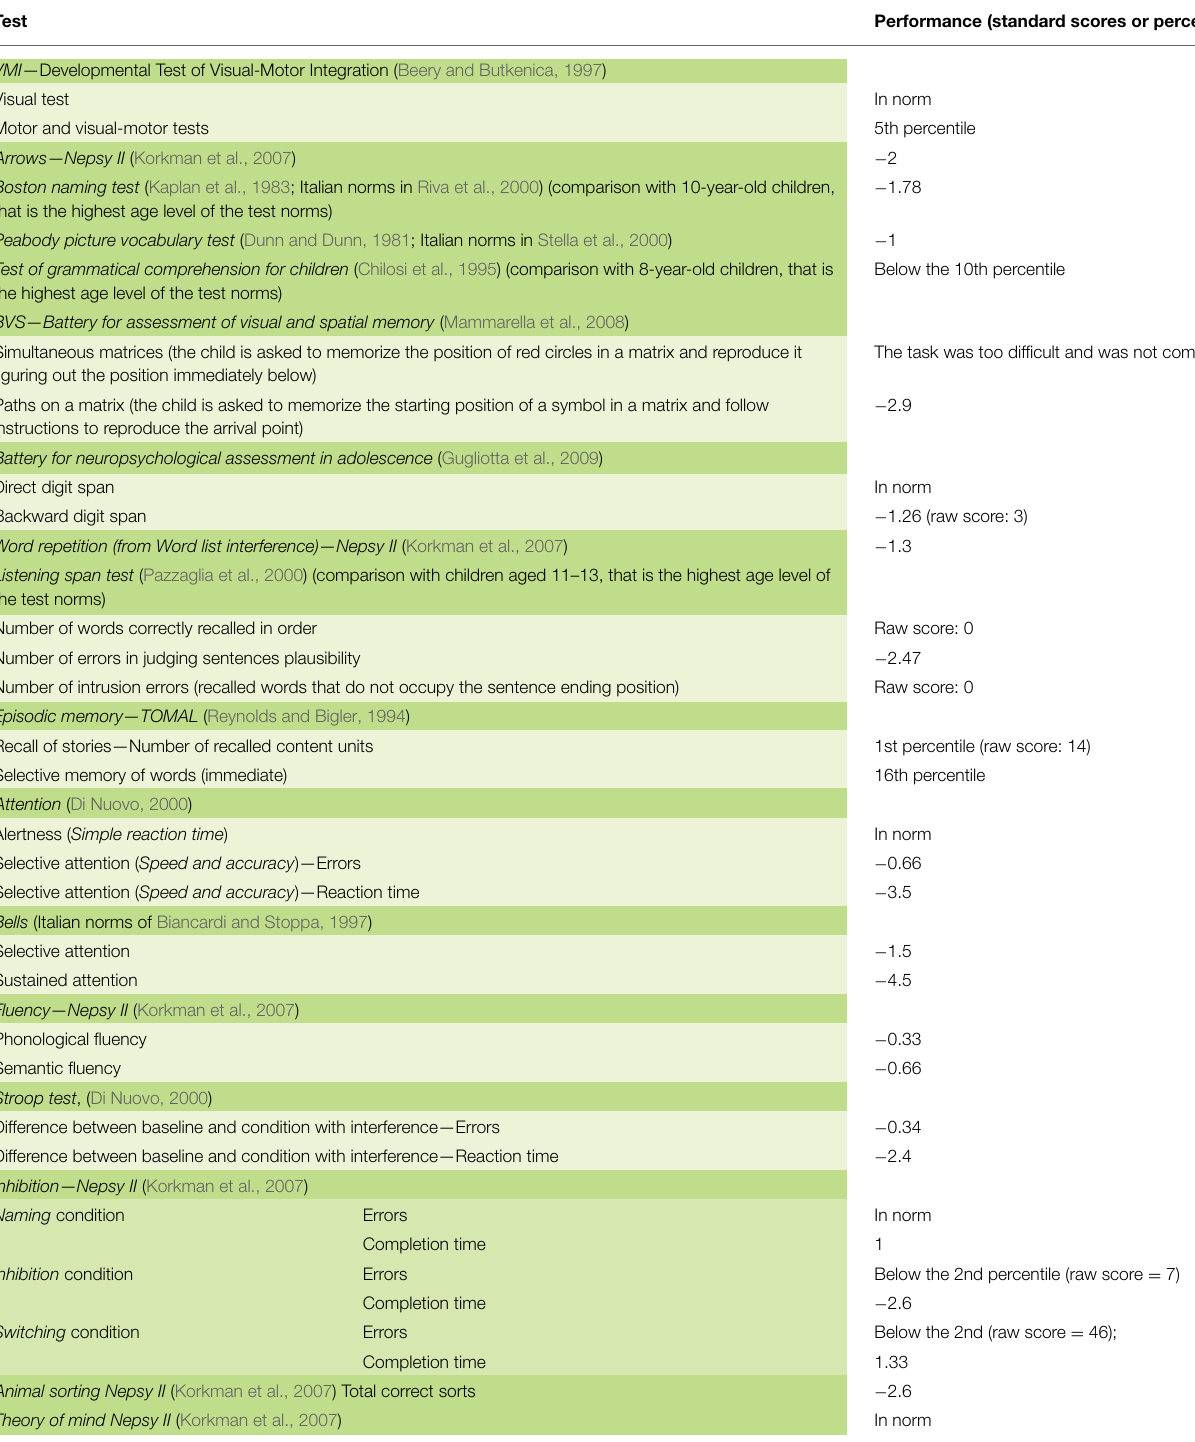
TABLE 1 | Davide’s assessment before intervention (age: 14 years and 2 months). Test Performance (standard scores or percentiles *